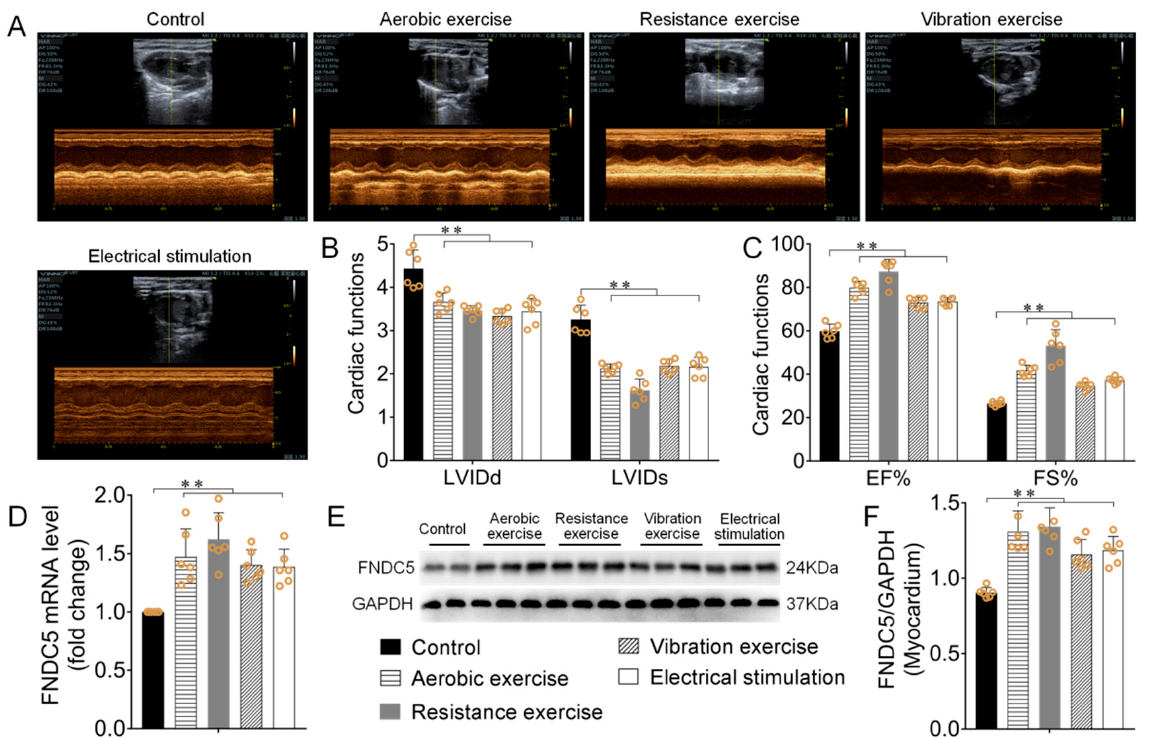
Figure 2. Different types of exercise and skeletal muscle electrical stimulation intervention enhanced myocardial irisin/FNDC5 expression and cardiac function. ( A – C ) The cardiac function of mice after different types of exercise and skeletal muscle electrical stimulation intervention. ( D – F ) The effect of mice’s myocardial Irisin/FNDC5 mRNA and its protein expression. Data are expressed as mean ± SEM ( n = 6). ** p < 0.01. Abbreviations: FNDC5: transmembrane protein fibronectin type III domain protein 5, LVIDs: Left ventricular internal diameter at end systole, LVIDd: Left ventricular internal diameter at end diastole, EF: ejection fraction, FS: left ventricular fractional